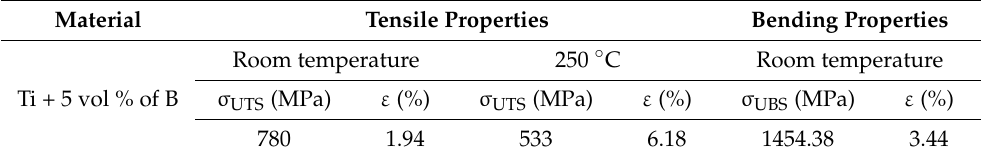
Table 4. Mechanical properties of in situ TMCs produced at 1000 ◦ C with 5 vol % of Boron. Material Tensile Properties Bending Properties Room Ti + 5 vol % of B